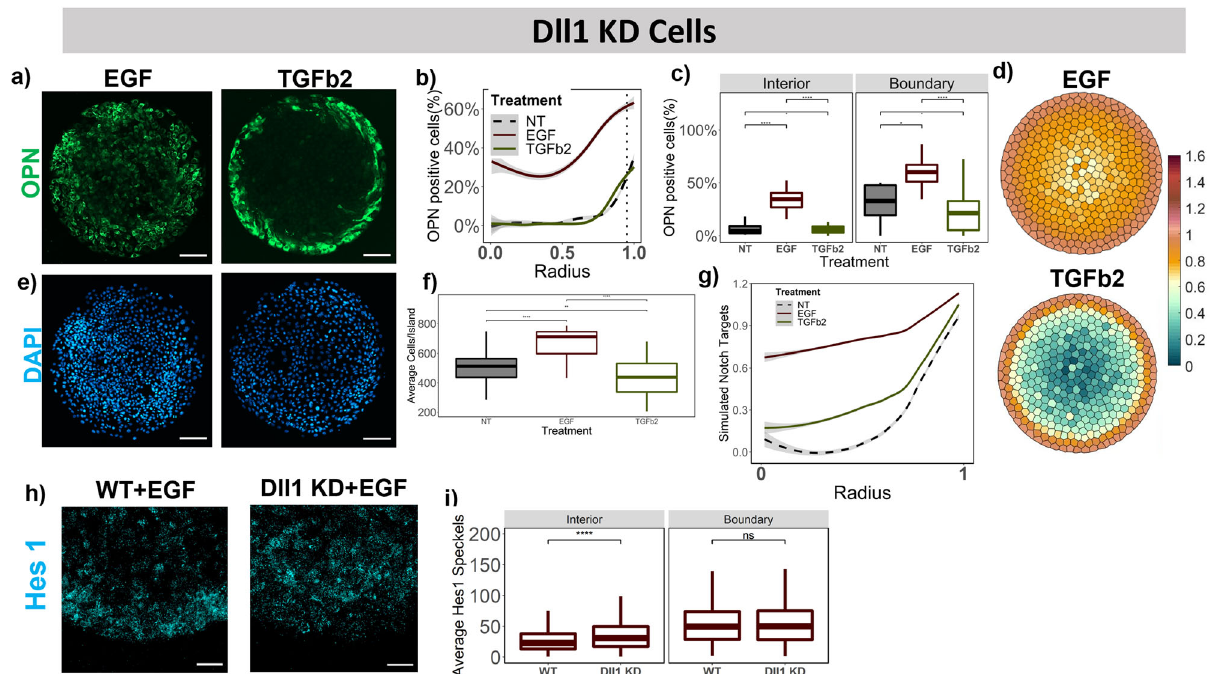
Fig. 6 Effect of extrinsic growth factor treatments in conjunction with Dll1 knockdowns. a Representative fl uorescent Images of EGF and TGF β 2 treated Dll1 KD BMELs on Col 1 microarrays on 25 kPa polyacrylamide hydrogels. Green: OPN, Blue: DAPI. Scale Bar: 100 μ m. b Quanti fi cation of average percent OPN + cells/island as a function of the radius. 0 is center, 1 is the edge, vertical dashed line at radius = 0.95. c Quanti fi cation of average percent OPN + cells/island in the interior (radius = 0 – 0.95) and at the boundary (radius = 0.95 – 1.00). e DAPI fl uorescent Images for EGF and TGF β 2 treated Dll1 KD BMELs on circular microarrays. Scale Bar: 100 μ m. f Quanti fi cation of Average Cell Number per individual island for EGF and TGF β 2 treated Dll1 KD BMELs. d Simulated Notch target genes on cells on a circular lattice, with in silico growth factor treatments and Dll1 KD. Heatmap color: arbitrary unit for Notch target genes. g Quanti fi cation of simulated Notch target genes in cells on a circular lattice for the in silico growth factor treatments and Dll1 KD. h ISH-HCR quanti fi cation of Hes1 mRNA, 40X confocal maximum intensity projection of wild-type and Dll1 KD BMELs treated with EGF on circular islands. i Quanti fi cation of average Hes1 mRNA speckles for images in 6n on the boundary versus the interior. Boxplots- ‘ . ’ : ns; * p -value < 0.05; ** p -value < 0.01; *** p -value < 0.001; **** p -value < 0.0001, calculated using Wilcox test in R. Line plots — Gray: 95% con fi dence interval. n ≥ 4 biological replicates (independent experiments) and n ≥ 15 technical replicates (individual islands). The No Treatment Control (NT) for the Dll1 KD BMELs is referred from Fig. 3b, c for statistical (Figs. 6e, f and 7e, f). The model simulation of JAG1 KD (betaJ reduced by 75%) and growth factor treatments (Eqs. (8 – 11)), resulted in a similar increase in simulated Notch targets with EGF, where the increase was limited to the boundary and drastic increase with TGF β 2 simulations, where the increase was across the whole island (Fig. 7d, g).